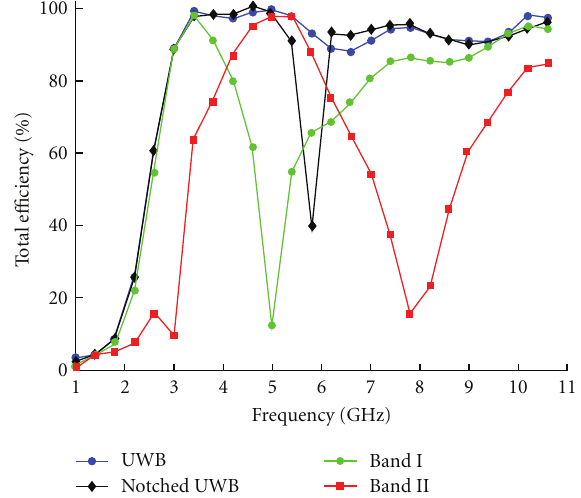
Figure 10: Simulated total e ffi ciency when the antenna is operating in di ff erent